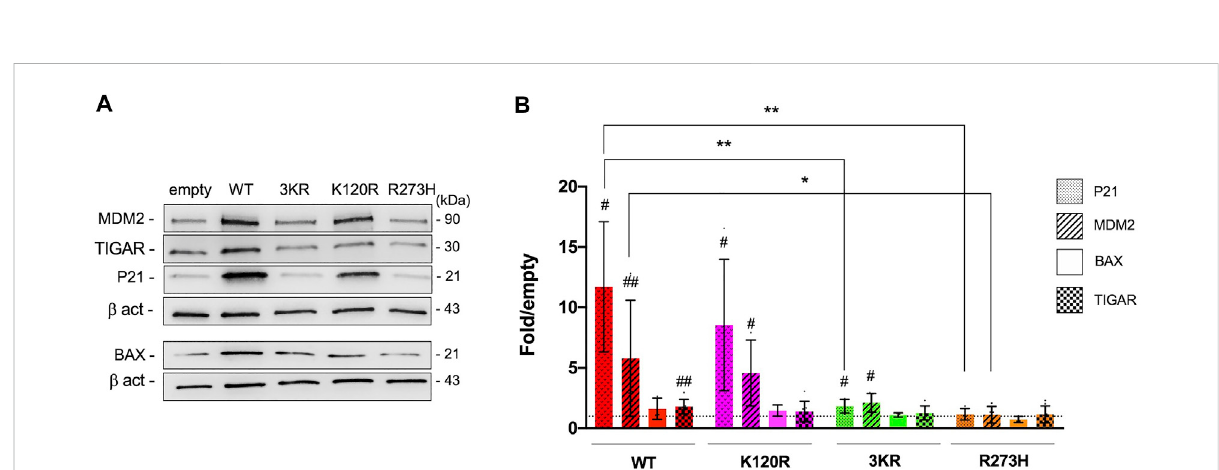
FIGURE 2 ModulationofendogenousP53targets byp53 WT ,p53 K120R , p53 3KR , andp53 R273H in HCT116 TP53 − / − cells. (A) Representative western blots showing the level of MDM2, TIGAR, P21, BAX and Beta-actin ( β -act) endogenous proteins in HCT116 TP53 − / − cells transiently expressing p53 WT , p53 3KR , p53 K120R , and p53 R273H . (B) Histogram represents the amount of P21, MDM2, BAX, and TIGAR proteins detected in HCT116 TP53 − / − transfected cells and normalized for β -act. Data are reported as mean± SD and are obtained from atleastthree independentexperiments.The levelsofthedifferent proteins are calculated as fold over the level of the same proteins found in cells transfected with the empty vector (# p < 0.05; ## p < 0.005; t Student); the dotted line corresponds to one-fold over empty. The symbols * and ** indicate signi fi cant differences of protein expression (with p =0.0130 and p ≤ 0.0091,respectively)betweencellsexpressingp53 WT (WT)andcellsexpressingp53 K120R (K120R),p53 3KR (3KR)orp53 R273H (R273H). MDM2 induction by p53 3KR results not quite signi fi cantly different ( p = 0.0563) from the corresponding induction by p53 WT